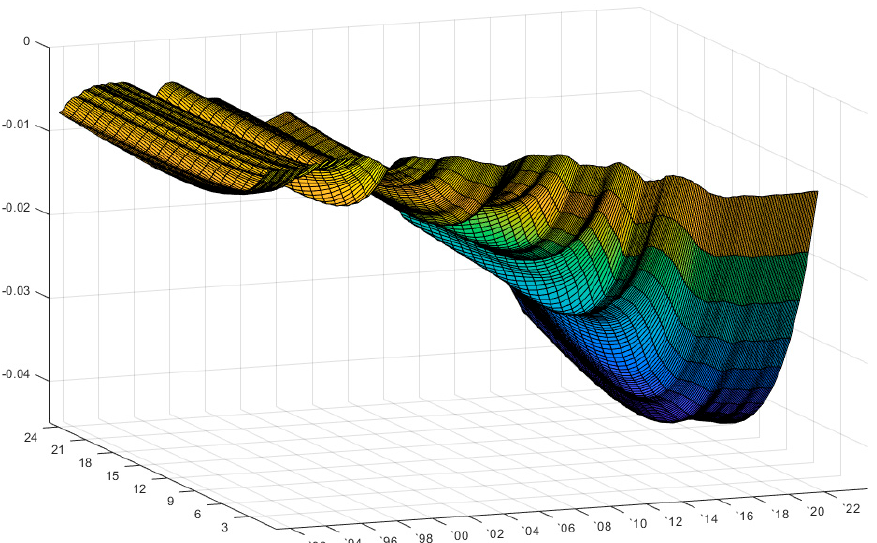
Figure 7. Time-varying impulse response to housing prices (based on KB Price Index). Note: X-axis: time of impulse response; Y-axis: magnitude of impulse response; and Z-axis: duration of impulse response (months). Source: estimated by the authors with the TVP-VAR model.